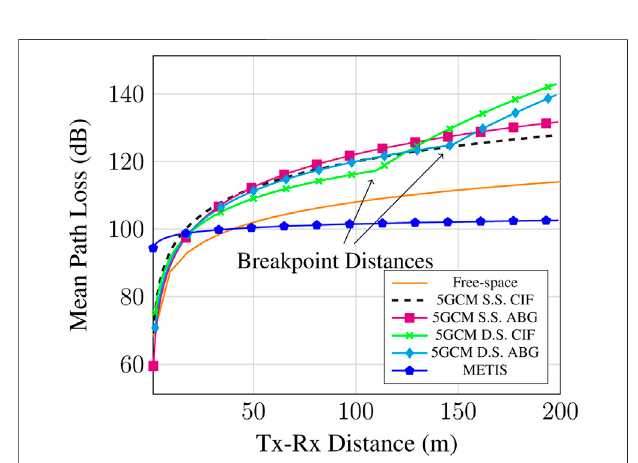
FIGURE 9 | Path loss versus Tx-Rx distance comparison among six different channel models in NLOS InH shopping mall scenario.